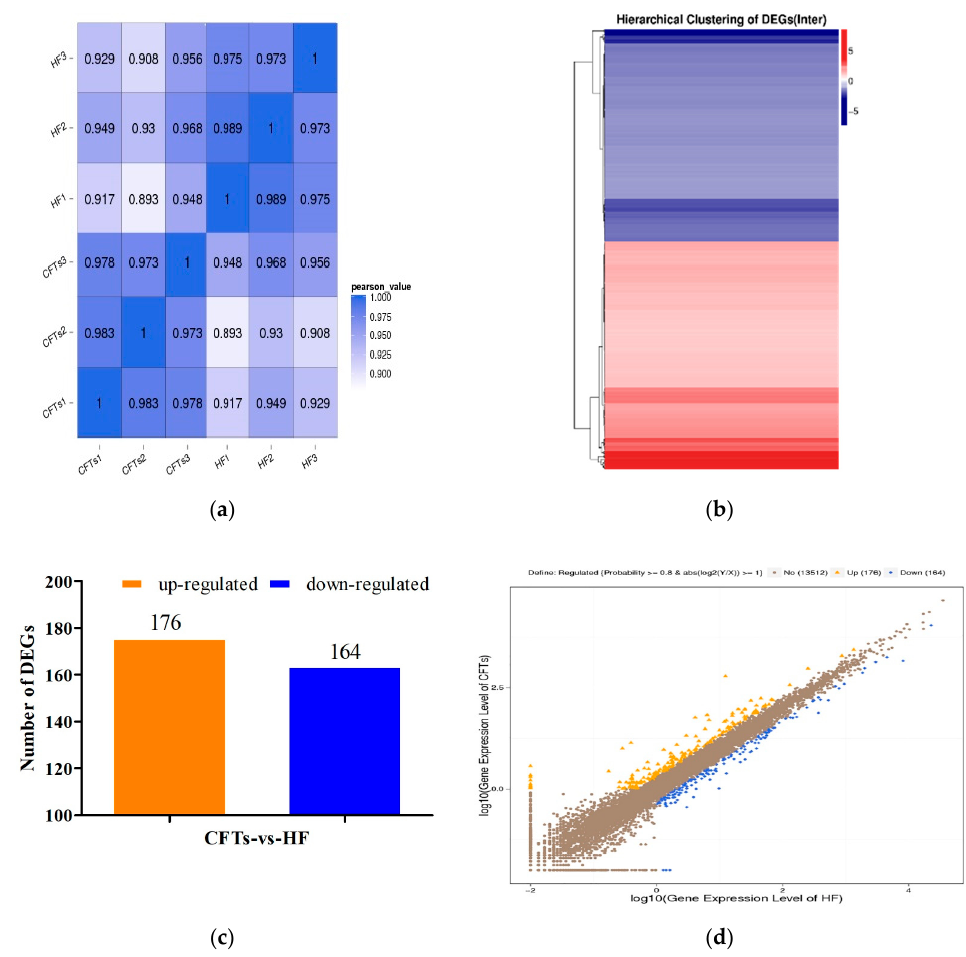
Figure 8. Differential gene expression analysis (HF vs CFTs). ( a ) Heatmap of correlation coefficient values; ( b ) Intersection heatmap of DEGs; ( c ) Statistic of differentially expressed genes; ( d ) Scatter plots of all expressed genes.